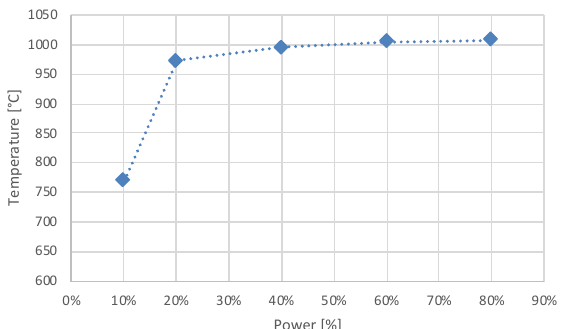
Figure 17. Irradiance [W/cm 2 ] reached with all lamps switched on; ( a ) 40% of power (1600 W); ( b ) 80% of power (3600 W); the coordinates are expressed in cm from the center of the workbench; the colormap scale is referred to both graphs.